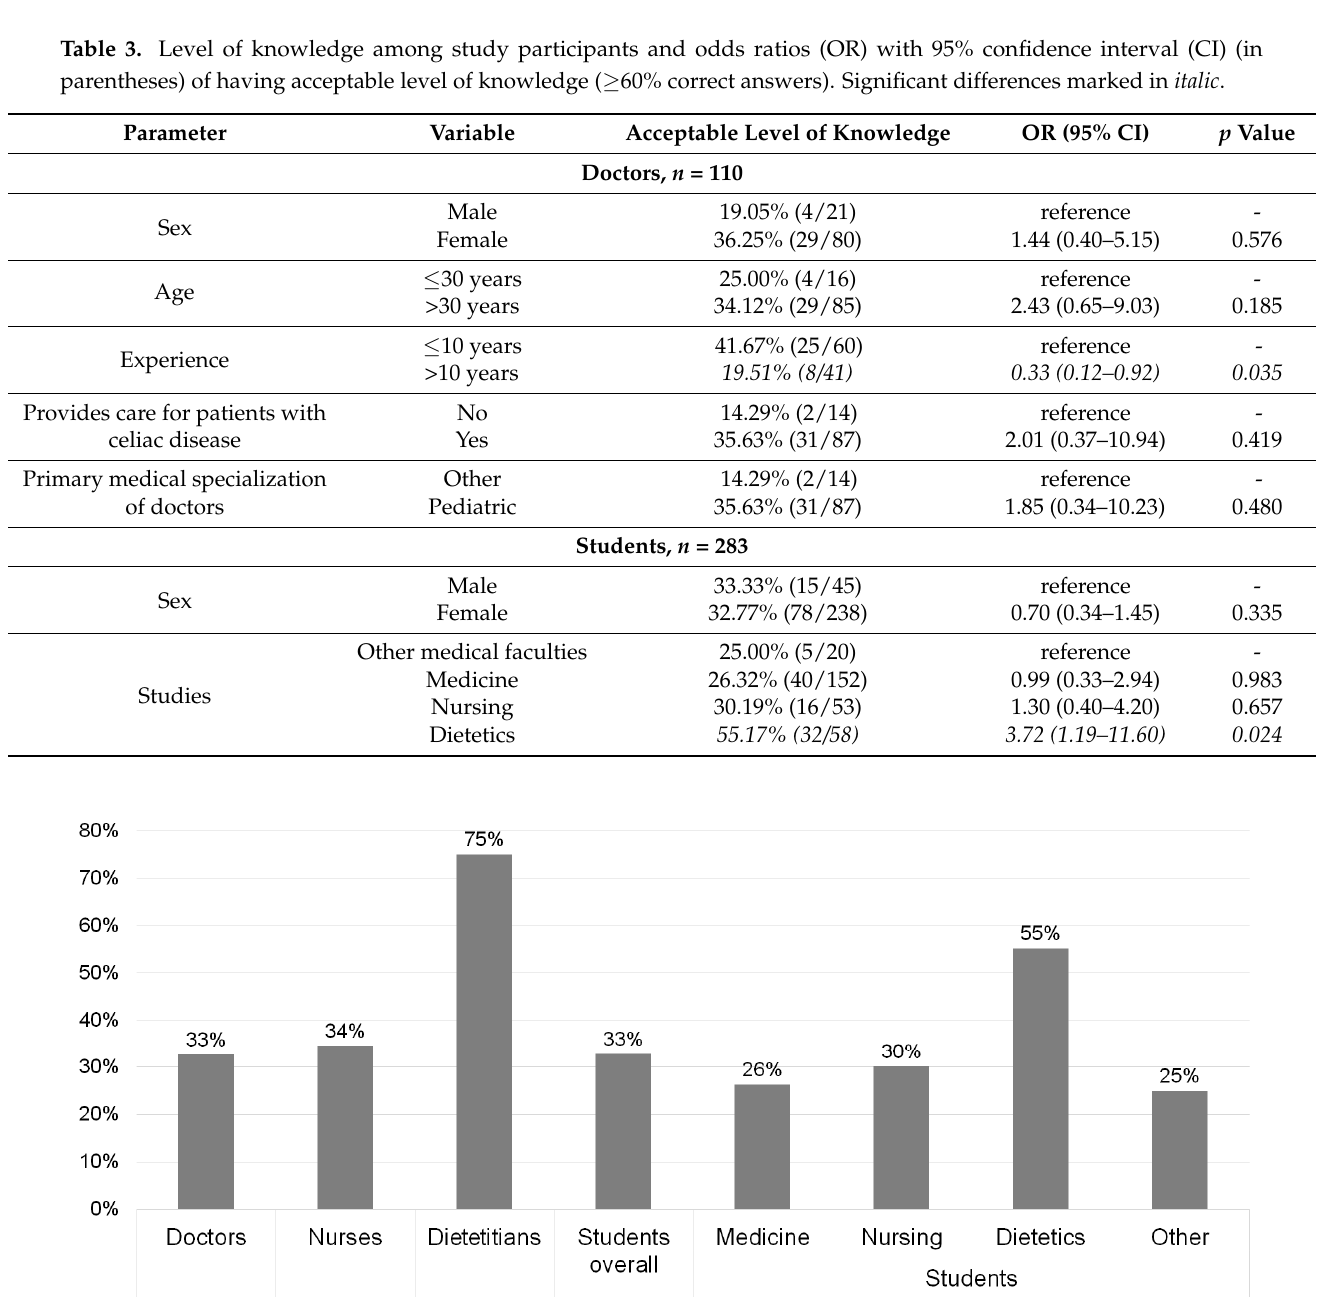
Figure 1. Acceptable level of knowledge ( ≥ 60% correct answers) for each occupation.